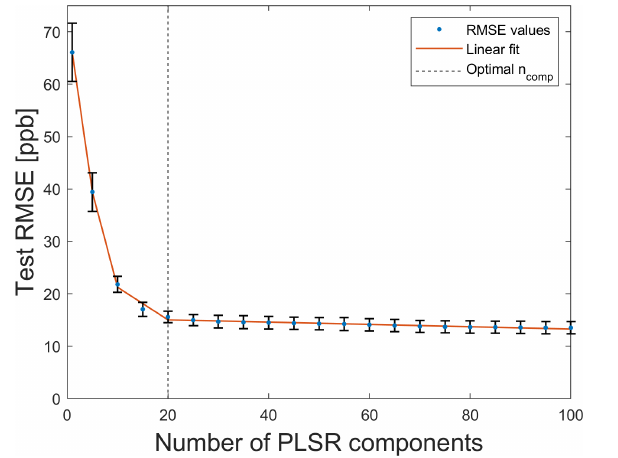
Figure 8. Elbow method applied to the T − RMSE curve for 10 trials. The optimal number of PLSR components is